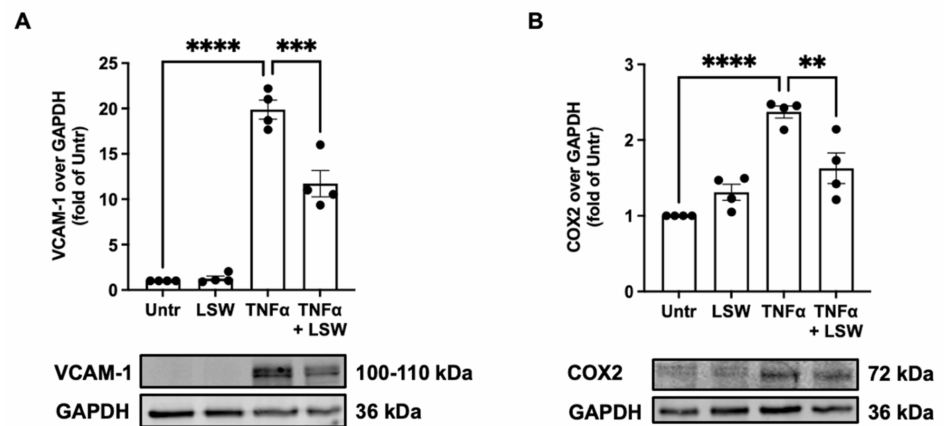
Figure 3. Effect of LSW treatment on TNF α -induced inflammation in EA.hy926 cells. The cells were treated with LSW (50 µ M) for 18 h before TNF α (10 ng/mL) stimulation for 6 h, followed by detecting the protein expression of VCAM-1 ( A ) and COX2 ( B ) expression by Western blotting. Protein bands were normalized to GAPDH. Data were normalized to the untreated group (Untr). **, p < 0.01; ***, p < 0.001; ****, p <